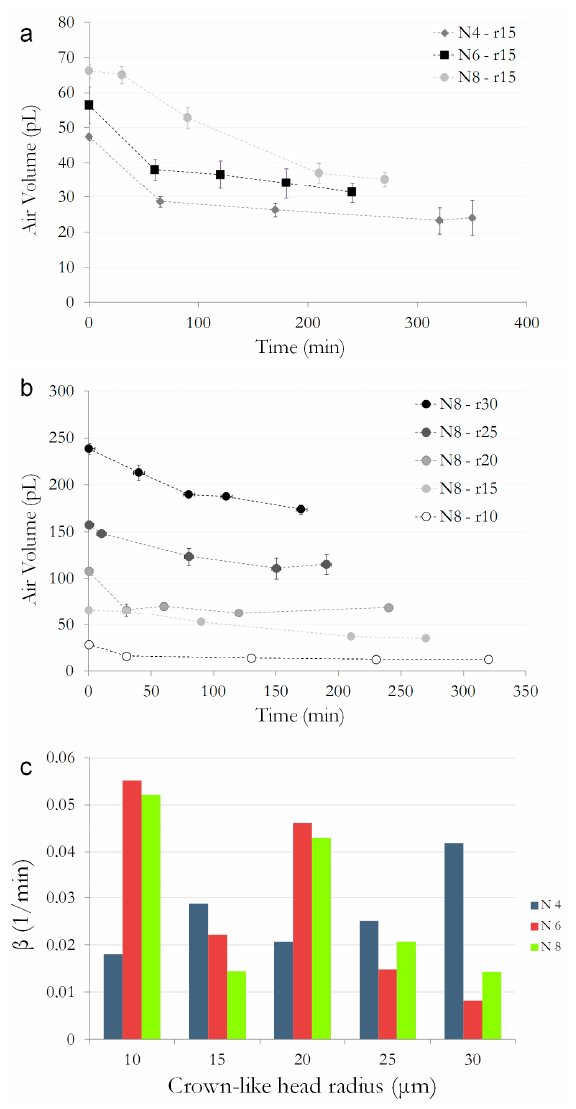
Figure 4. ( a ) Trend of the air volume trapped inside the crown-like heads with a radius of 15 µm for different numbers of filaments; ( b ) Variation over time of the volume of air retained inside the crown-like heads in the case of N = 8, for different values of the radius;( c ) Comparison, for all designs, of the coefficients β related to the rate of reduction of air inside the heads.